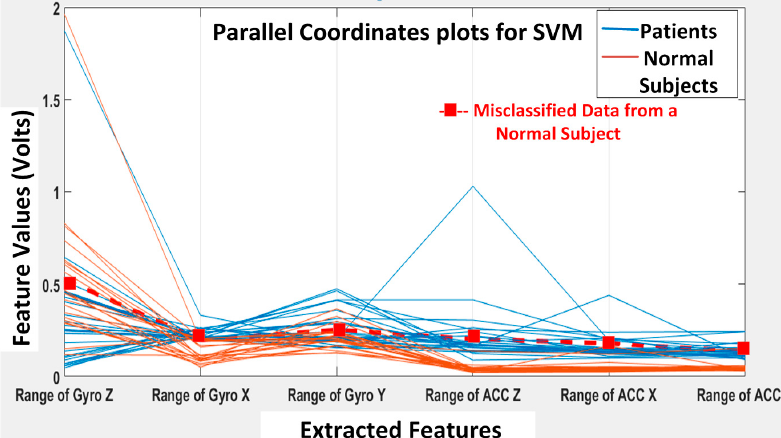
Figure 15. SVM classification results: misclassification shown in the feature space with only one case misclassified (i.e., DGI Test 7 of the first normal subject is classified as the “patient” class).